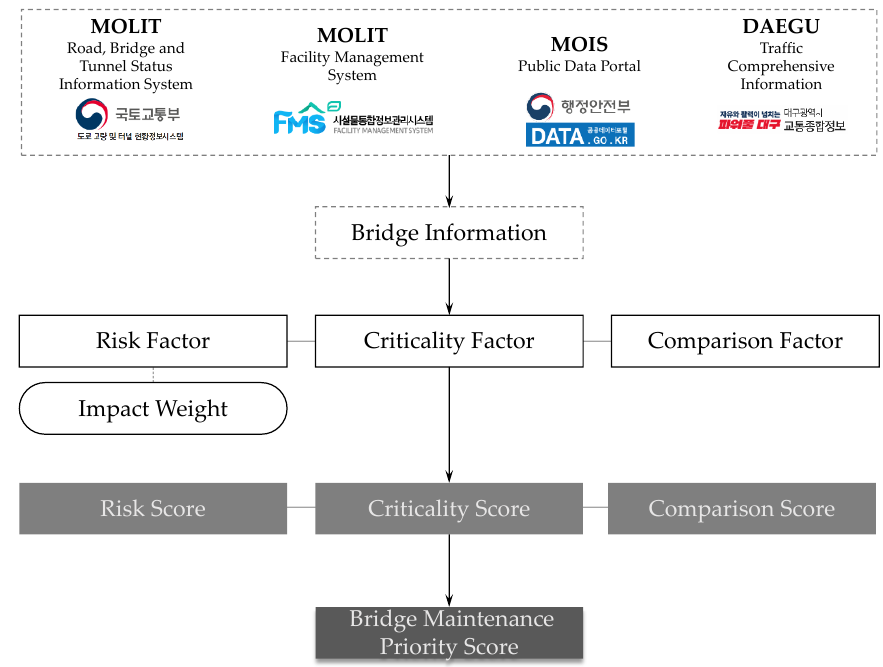
Figure 2. Bridge maintenance priority selection model derivation process.